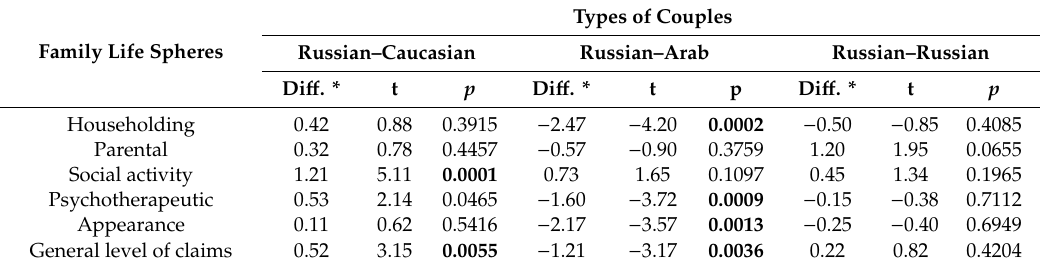
Table 4. The consistency of role claims (willingness to assume responsibility for the areas of family life) of spouses in di ff erent types of couples. Types of Couples Family Life Spheres Russian–Caucasian Di ff . *